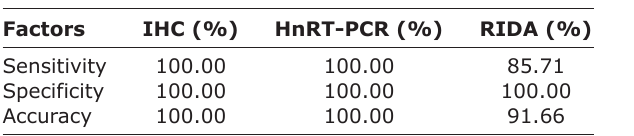
Table-6: Comparison of sensitivity, specificity and accuracy of three diagnostic